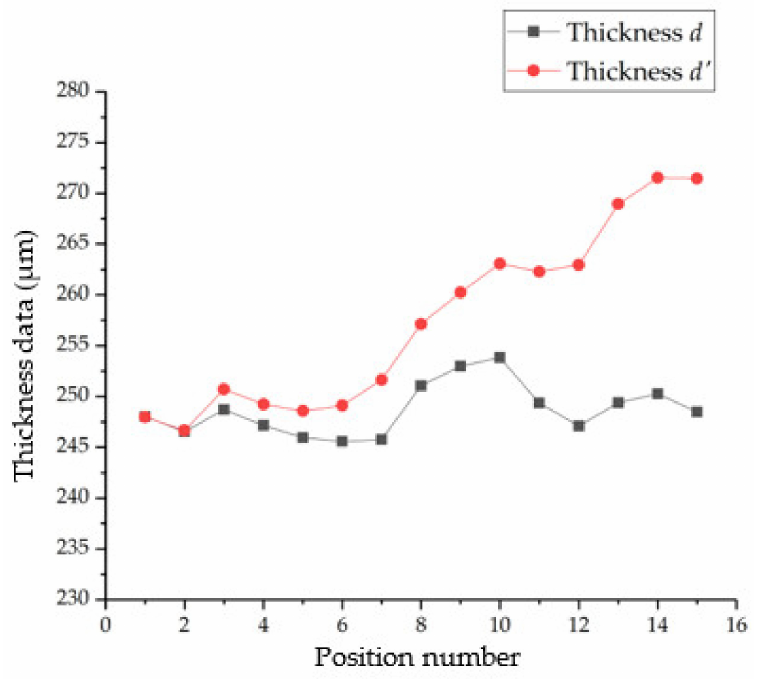
Figure 21. The thickness measurement data of Sample